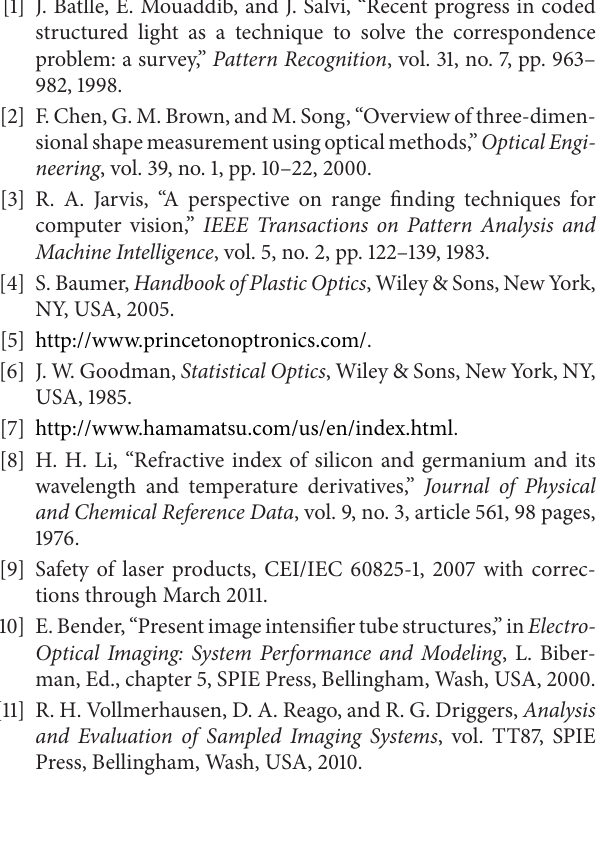
predictionMin. predictionMax. prediction Mean